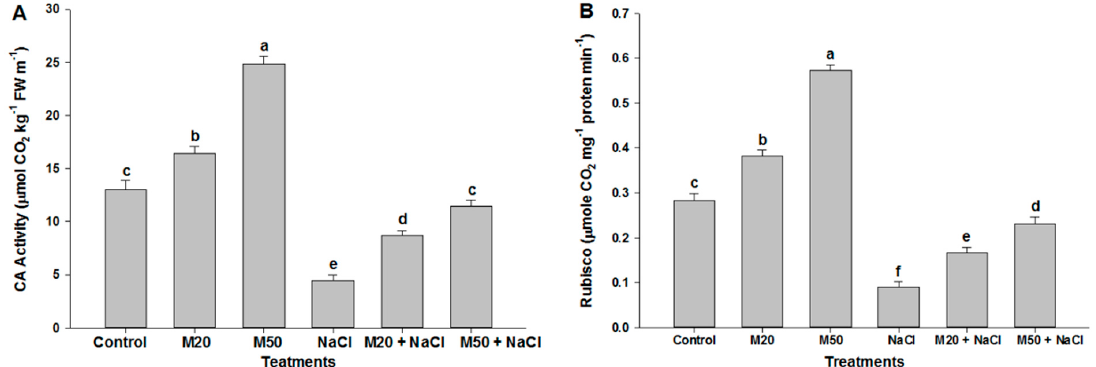
Figure 3. E ff ect of melatonin on ( A ) carbonic anhydrase (CA) and ( B ) ribulose-1,5-bisphosphate carboxylase / oxygenase (Rubisco) activity in leaves of tomato seedlings under salinity. Data represent mean of 4 replicates with bars indicating SE. The bars labelled with di ff erent letters are significantly di ff erent at p < 0.05%. [DDW (control), 20 µ M melatonin (20M), 50 µ M melatonin (50M), 100 mM NaCl